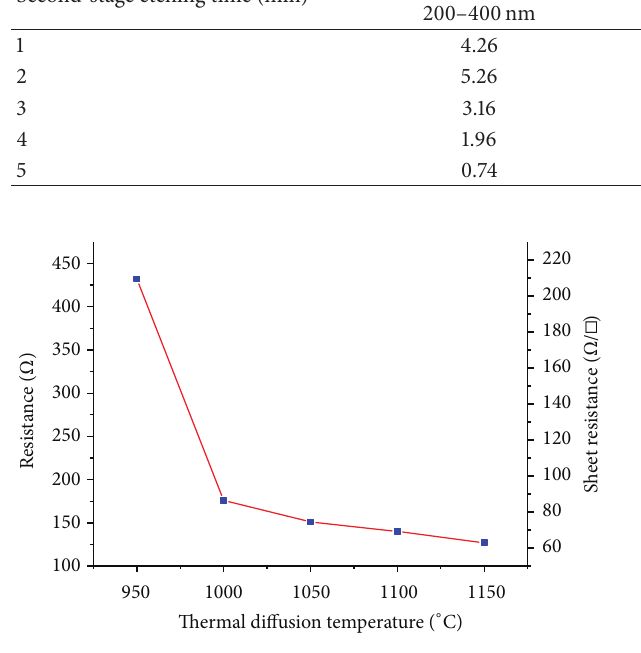
Figure 5: Sheet resistance measurements.